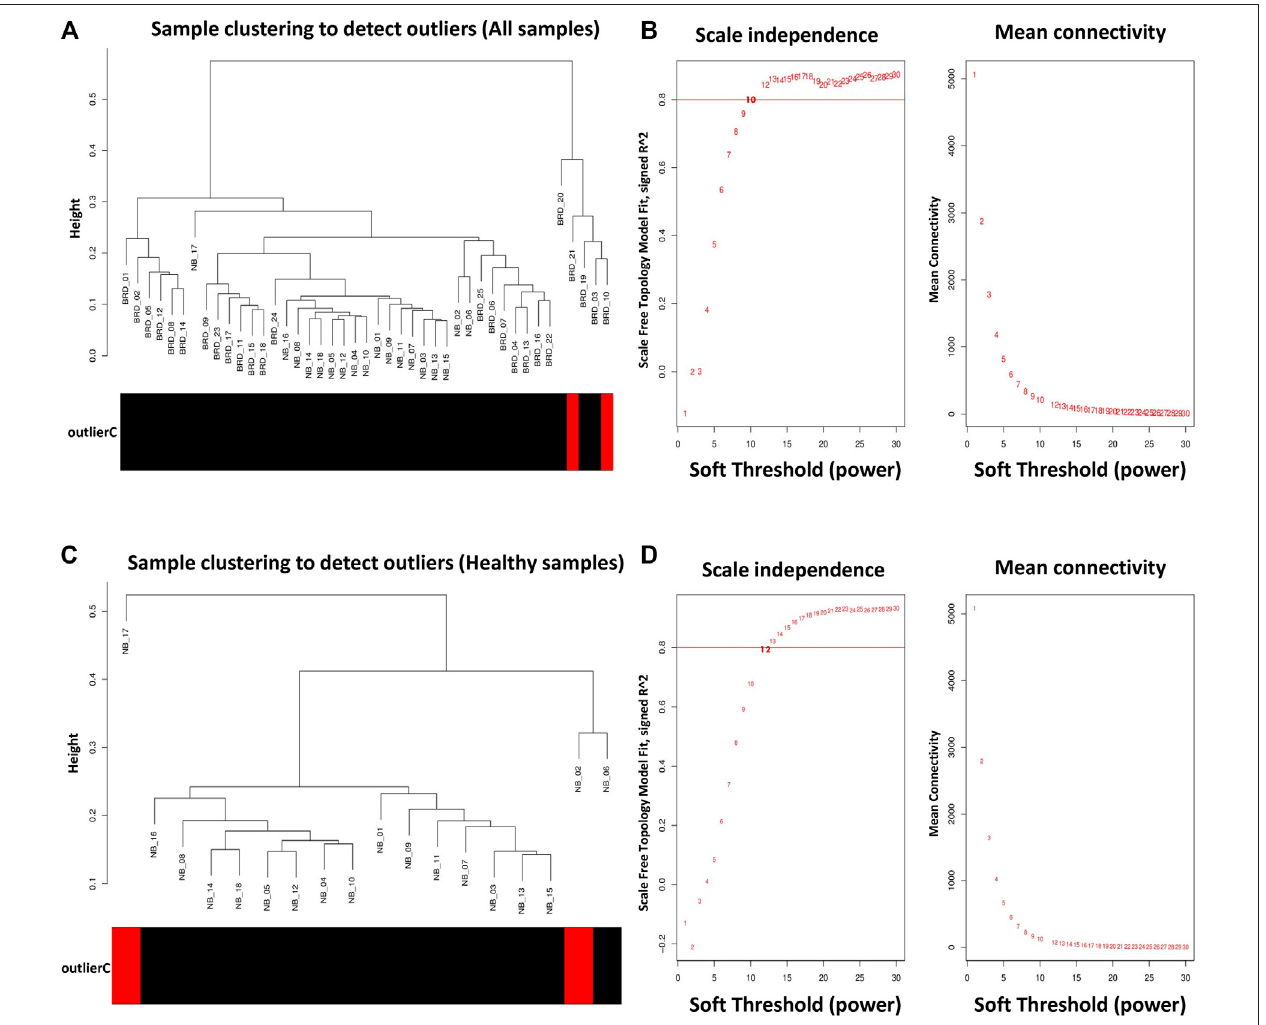
FIGURE 2 | Sample clustering to detect outliers and network topology analysis. (A) All samples except GSM4943645 and GSM4943656 were clustered and then selected for module – trait relationships analysis. (B) Scale-free topology fi tting index (left) and mean connectivity (right) for different soft-threshold powers ( β ). For module – trait relationships analysis, coexpression network was constructed at β (cid:2) 10 whose scale-free topology fi tting index ( R 2 ) was ≥ 0.80. (C) All samples except GSM4943661 and GSM4943667 were clustered and then selected for module preservation analysis. (D) Scale-free topology fi tting index (left) and mean connectivity(right)fordifferentsoft-thresholdpowers( β ).Formodulepreservationanalysis,co-expressionnetworkwasconstructedat β (cid:2) 13whosescale-freetopology fi tting index ( R 2 ) was > 0.80.